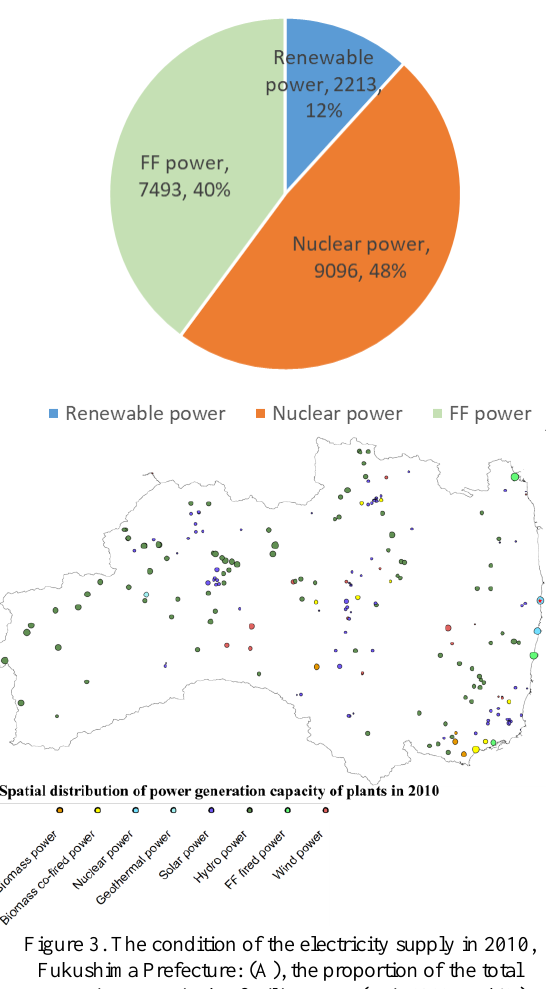
Figure 3. The condition of the electricity supply in 2010, Fukushima Prefecture: (A), the proportion of the total generation capacity by facility types (unit: MW and %). Biomass co-fired power plants were classified as FF power; (B), the spatial distribution of the generation capacity of power plants (231). The sizes of dots reflect the capacity of plants and the blue dot with a red star inside shows the plant with the largest